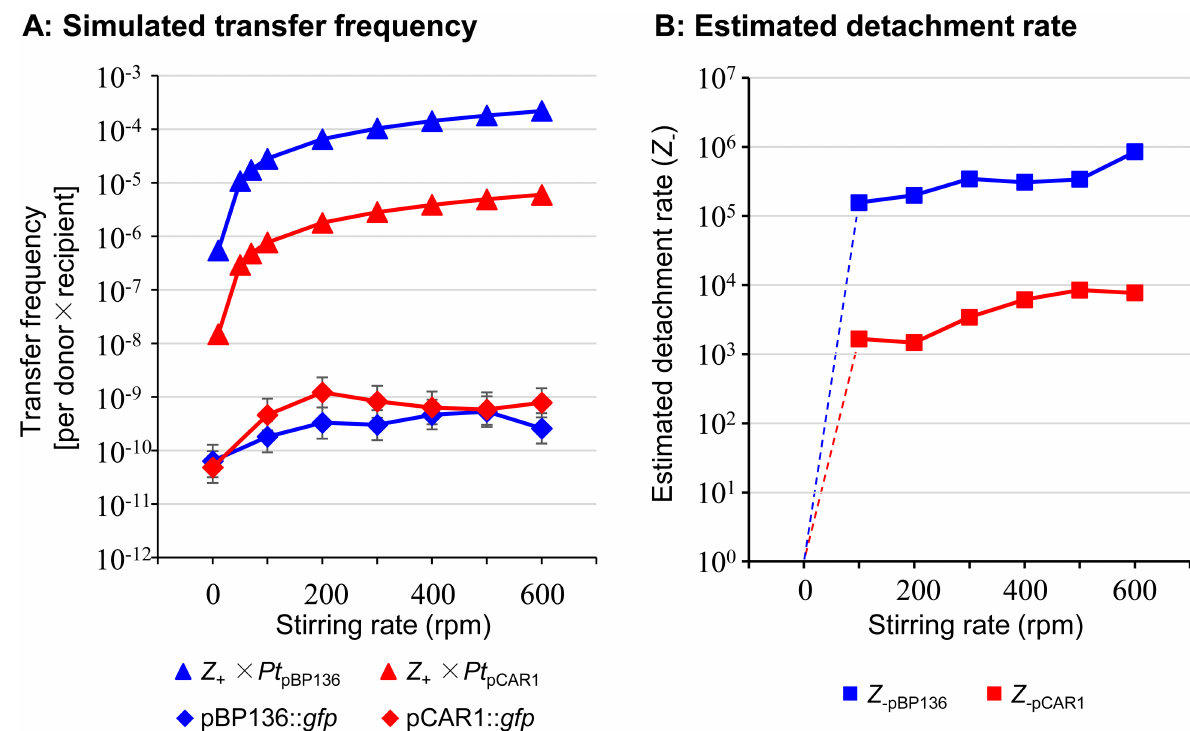
Fig 4. The simulated transfer frequency and detachment rates of plasmids. (A) The simulatedand experimental transfer frequency of pBP136:: gfp and pCAR1:: gfp in different stirring rates at cell density of 10 6 CFU/mL. Note that the simulatedtransfer frequencyare shown from 10 to 600 rpm. The experimental data of the number of transconjugants shown in Fig 3 are also shown in the graph for comparison, blue (pBP136:: gfp ) and red (pCAR1:: gfp ). (B) The estimated detachmentrates ( Z - ) in different stirring rates. Blue; Z -pBP136 and red; Z -pCAR1 . The detachment rate at 0 rpm could not be calculatedbut be closer to 0 (dash lines). The raw data of this figure are in S4 Table.